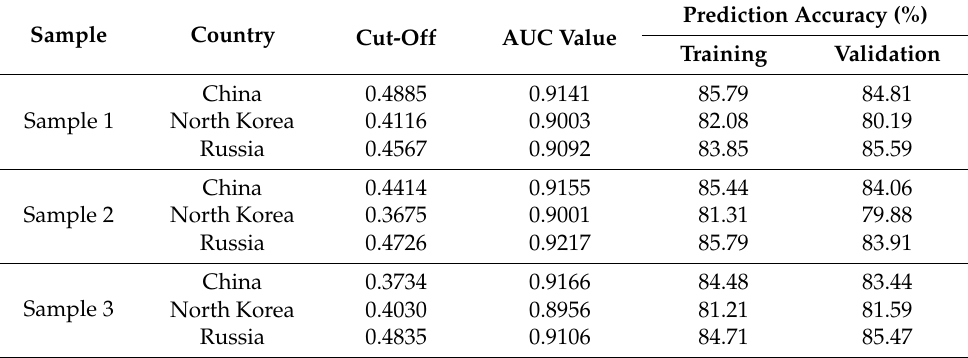
Table 5. Comparison of goodness-of-fit and prediction accuracy of LR models in different